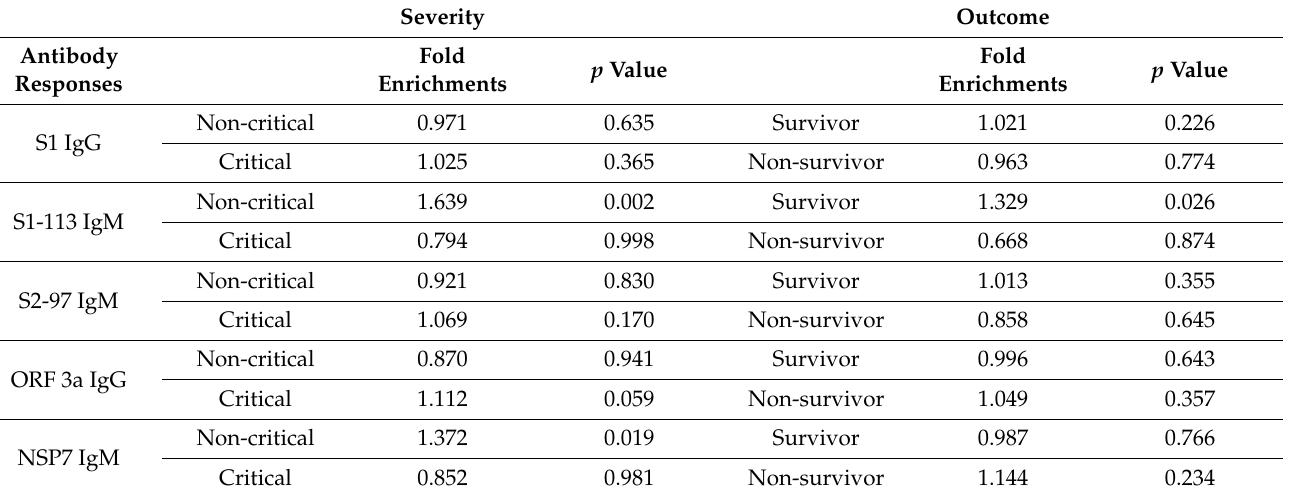
Table 5. Enrichment statistical analysis for COVID-19 patients with high antibody responses for